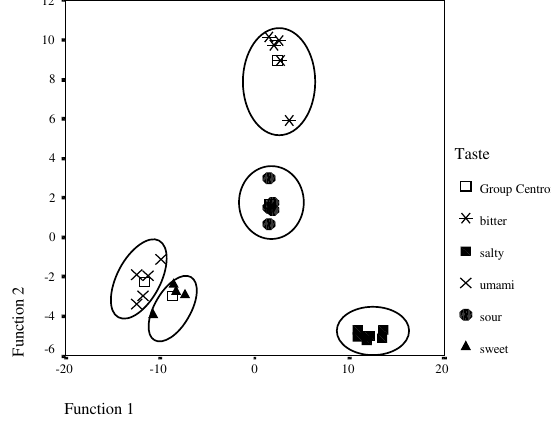
Fig. 8. Plot of CDA for five basic tatse